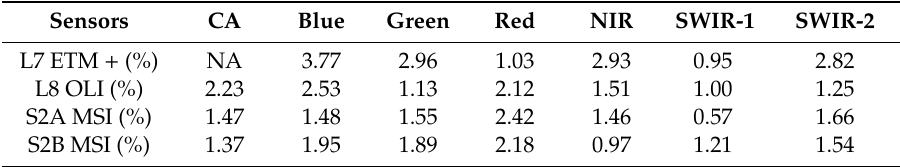
Table 7. Accuracy between measured and Libya 1 simulated values.